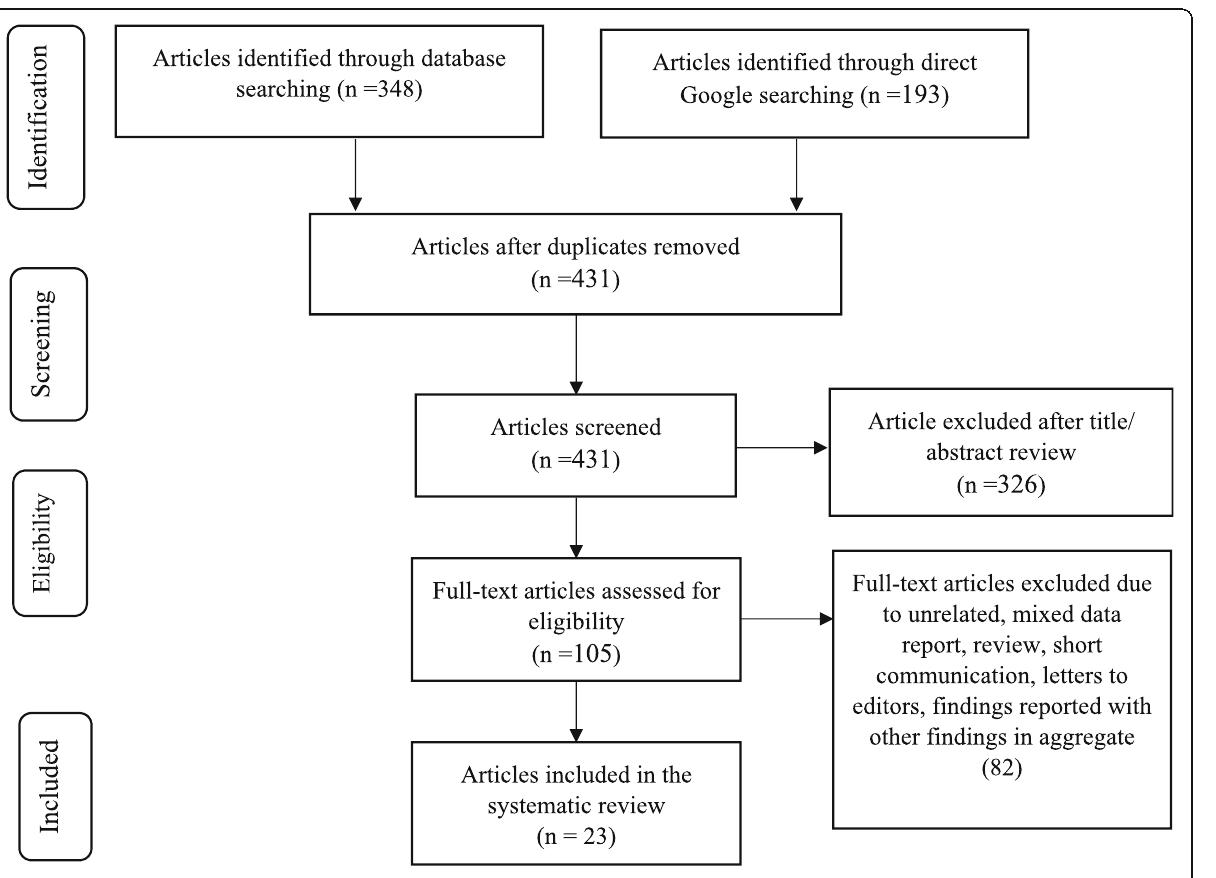
Fig. 1 The PRISMA flow diagram showing the study selection